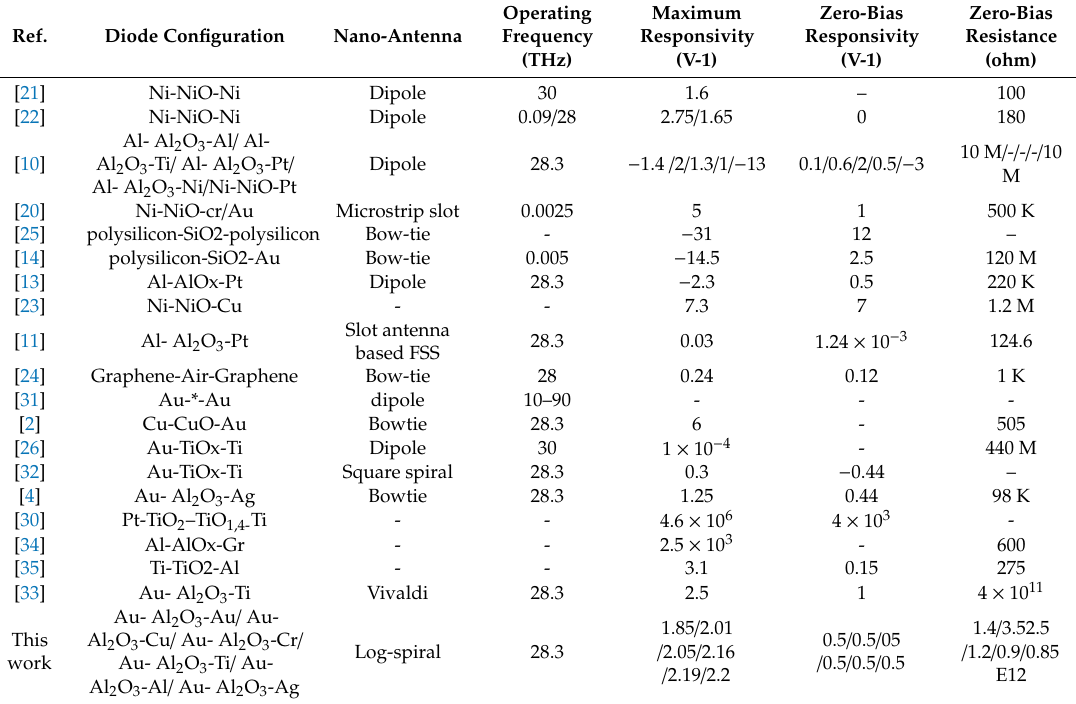
Table 1. Comparison of the proposed design with previous